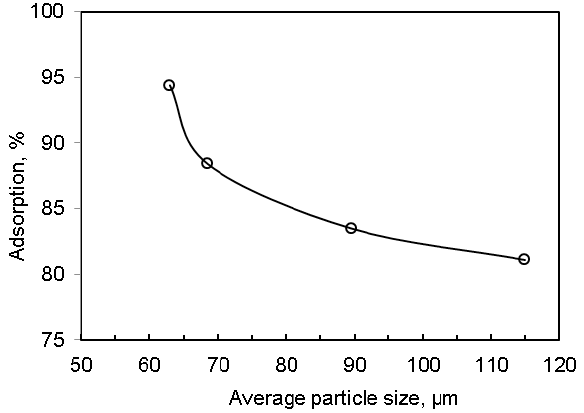
Fig.3. Effect of average particle size on dye adsorption